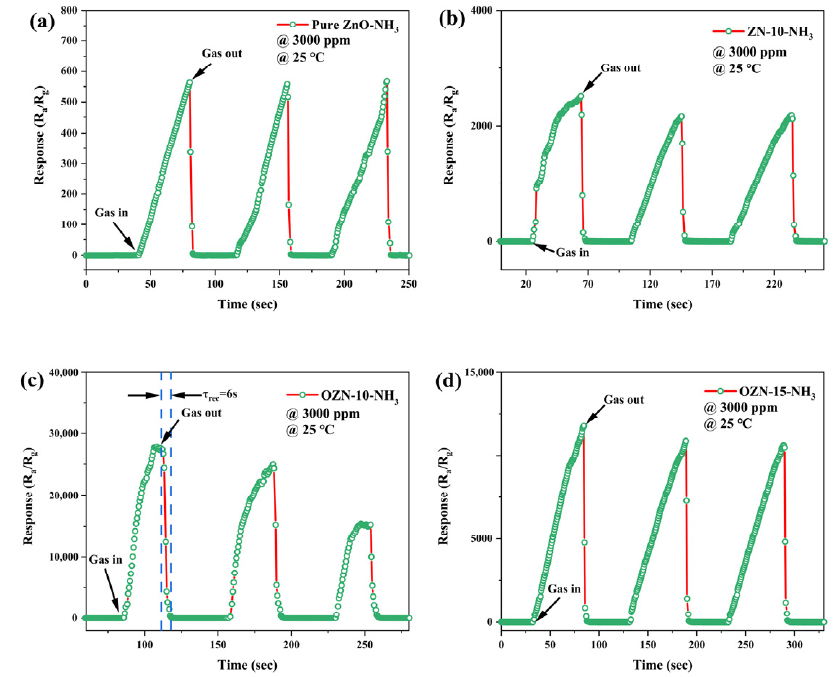
Figure 15. Dynamic response of saturated ammonia gas in ( a ) pure ZnO, ( b ) ZN-10, ( c ) OZN-10 and ( d ) OZN-15 (3000 ppm, 25 °C).